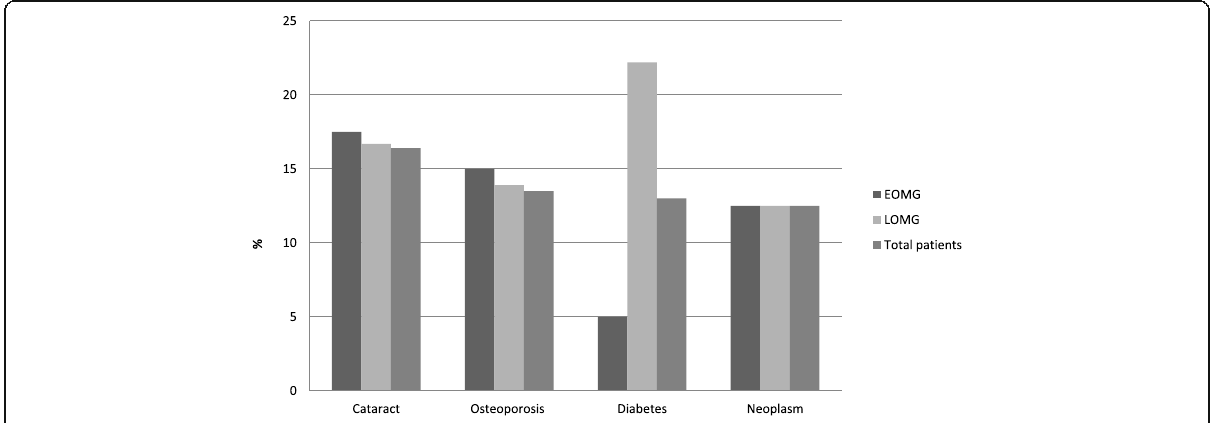
Fig. 1 Side effect. Abbreviations: EOMG = early onset myasthenia gravis, LOMG = late onset myasthenia